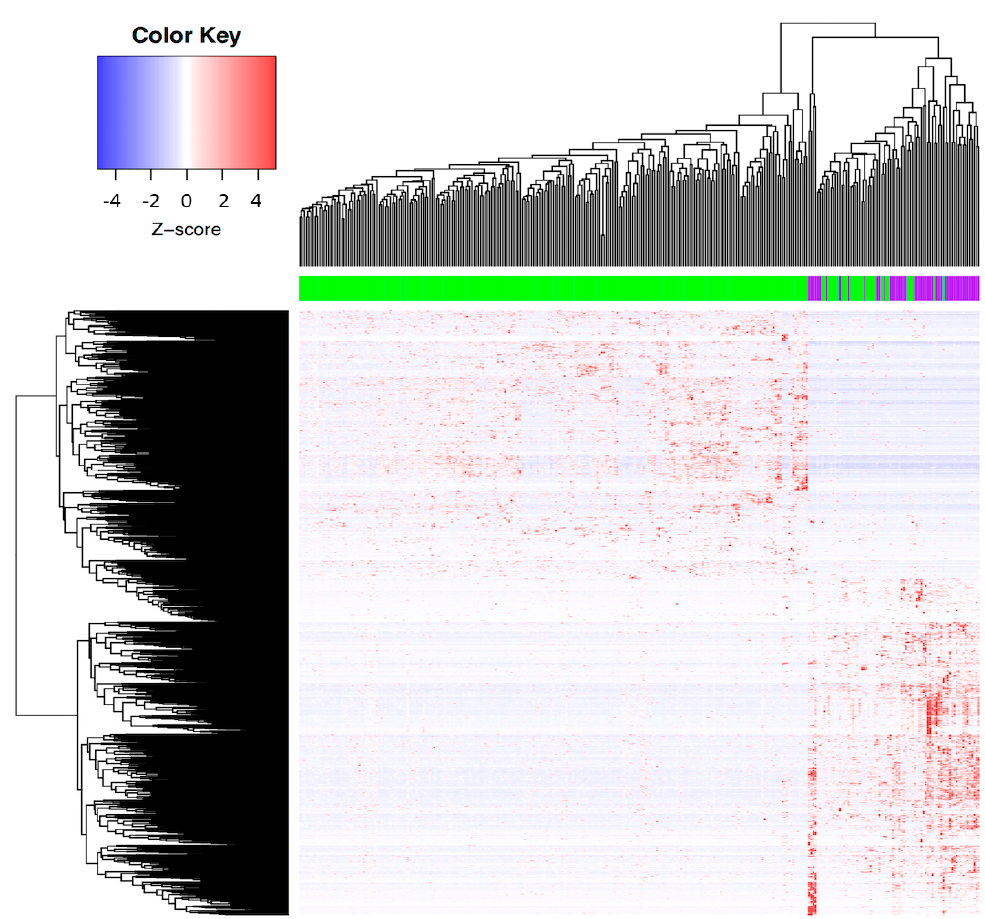
Figure 1. Molecular profile distinguishing cervical ADC and SCC in CC patients from the TCGA Database. Each column represents a patient with CC, and each row represents the expression of a gene. Gene expression changes are represented in blue (upregulated), red (downregulated), and white (no significant change or the absence of data). Patients with SCC are represented in green and ADCs in purple. There were 1768 unique DEGs between SCC and ADC tumors (adj p -value < 0.05, log2FoldChange >2 or <2), and most of the ADC tumors were clustered together. Table 2. Top 15 DEGs in ADC versus SCC in the TCGA dataset.